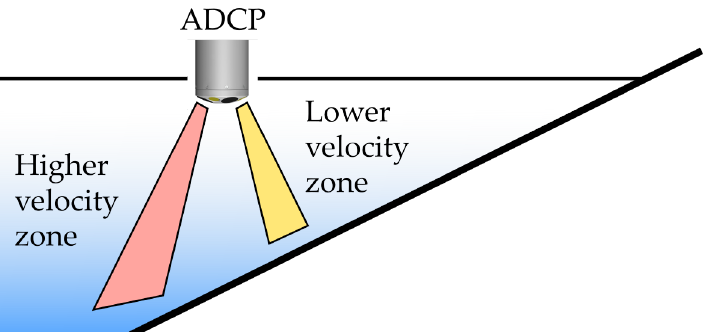
Figure 3. Signal interference near high-slope channel